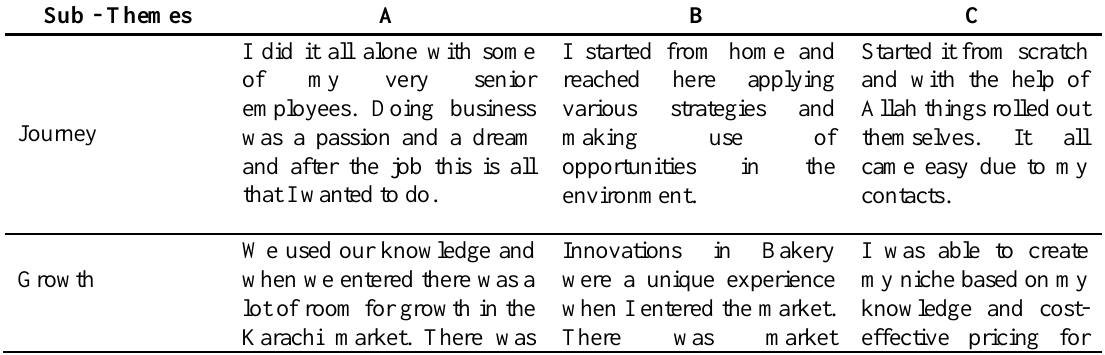
Table.2. Women’s Entrepreneurial